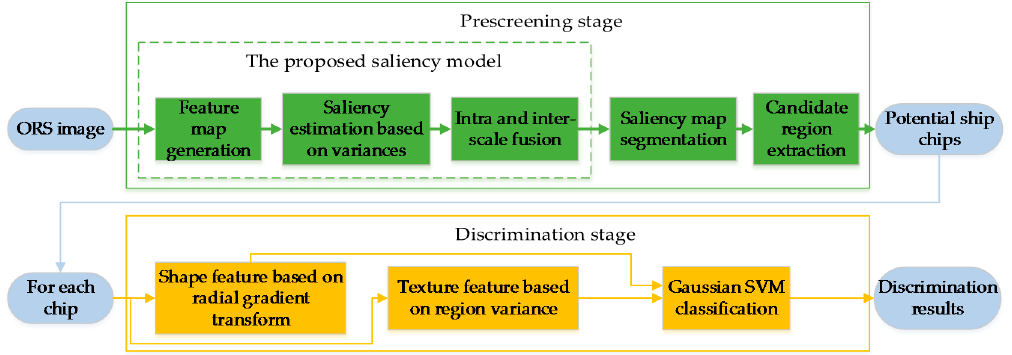
Figure 1. Diagram of the proposed hierarchical target detection scheme. The prescreening stage consists of saliency detection and binary segmentation. The discrimination stage includes feature extraction (radial gradient descriptor [19] and sigma set descriptor [20]) and classification by using Gaussian support vector machine (SVM) [21]. ORS: optical remote sensing.